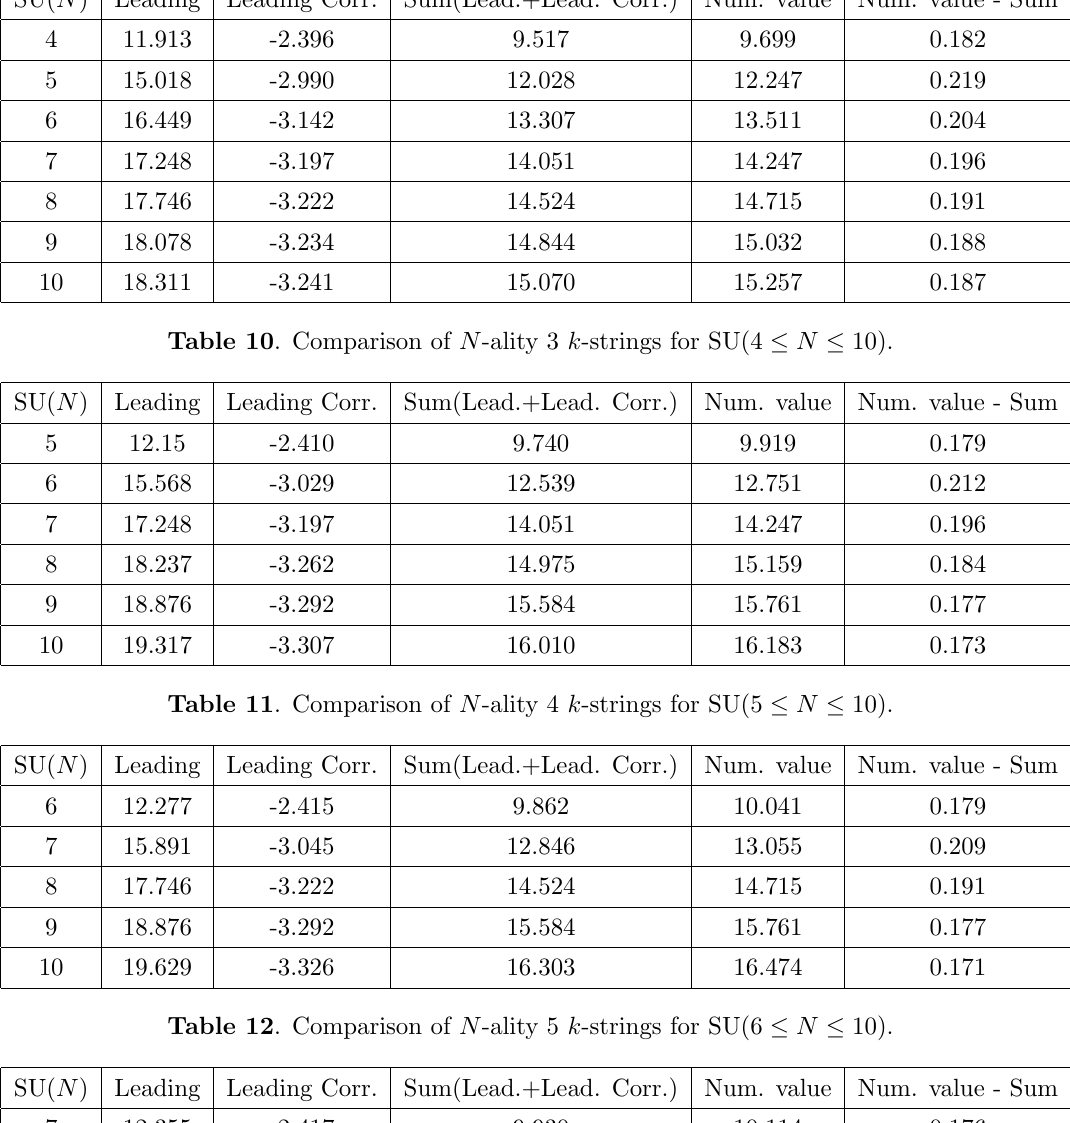
Table 12 . Comparison of N -ality 5 k -strings for SU(6